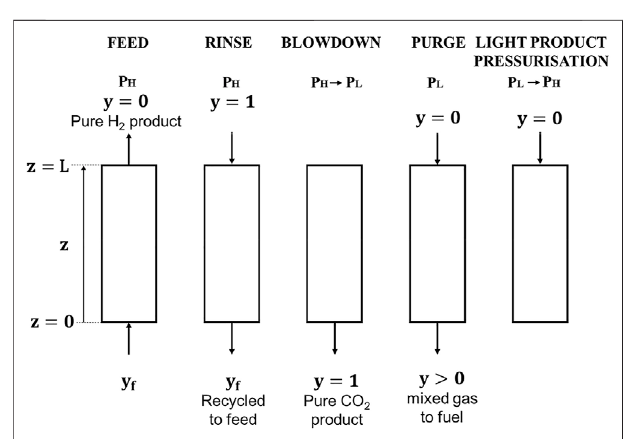
FIGURE 3 | Step sequence of a fi ve-step VPSA cycle for CO 2